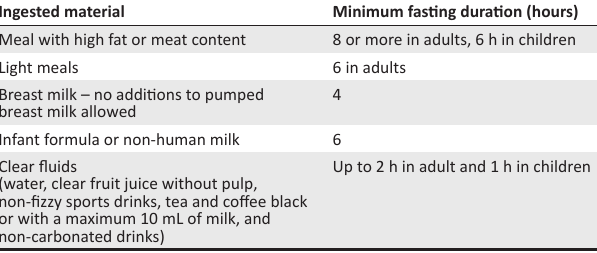
TABLE 3: Fasting guidelines in elective patients ( * ASA guidelines